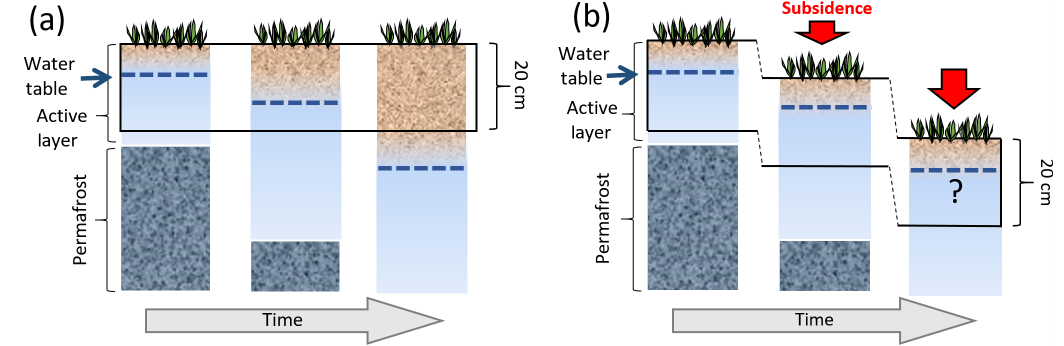
Figure 8. Schematic of changes in the soil column moisture (a) without subsidence (current models) and (b) with subsidence from thawing ice-rich permafrost (not represented by models), a process that may accumulate soil moisture and slow down drying over